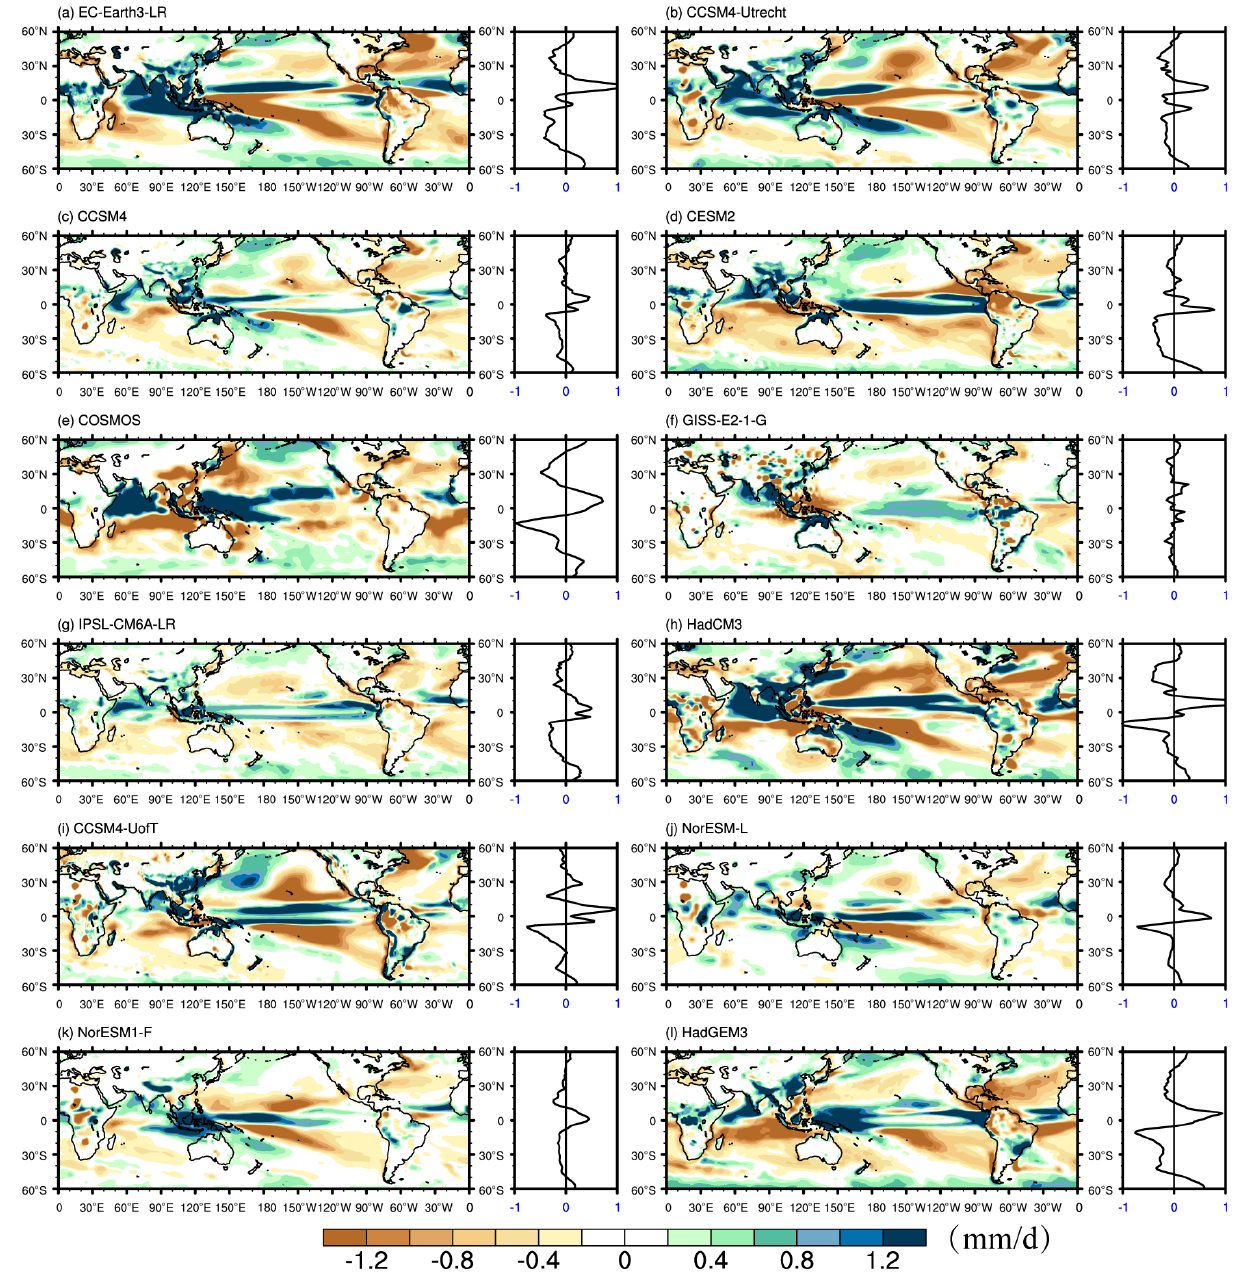
Figure 2. (a) Changes in the multi-model mean (MMM) PmE for the mid-Pliocene compared with the PI simulation (shading), overlaid by the climatological MMM PmE of the PI simulation (for the contours, a solid line indicates positive values and a dashed line indicates negative values). The red solid curves represent the zero value. (b) The zonal average of the change in PmE, where the shading indicates the interquartile range among models. (Units are mmd − 1